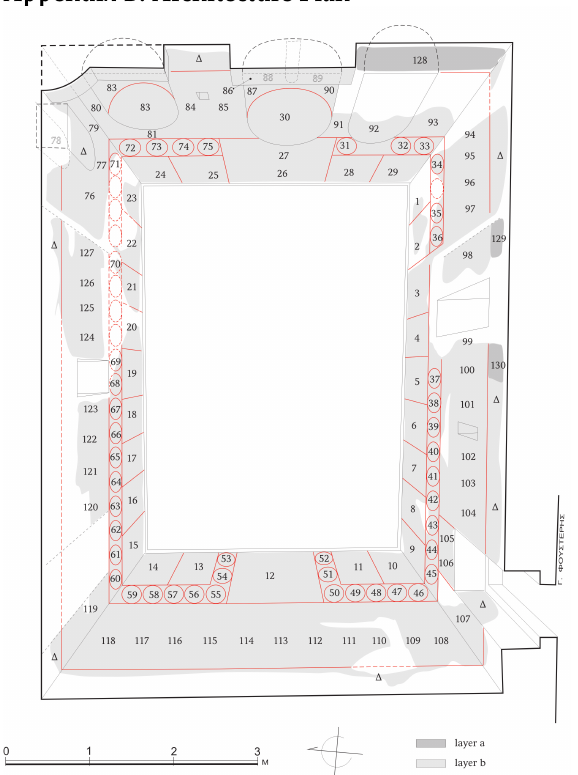
Figure A1. The architecture plan of Prophet Elijah in Paidonia, Ioannina, Greece as given in [14]. There are two layers of paintings (a and b). For each number, the particular description is given in Appendix